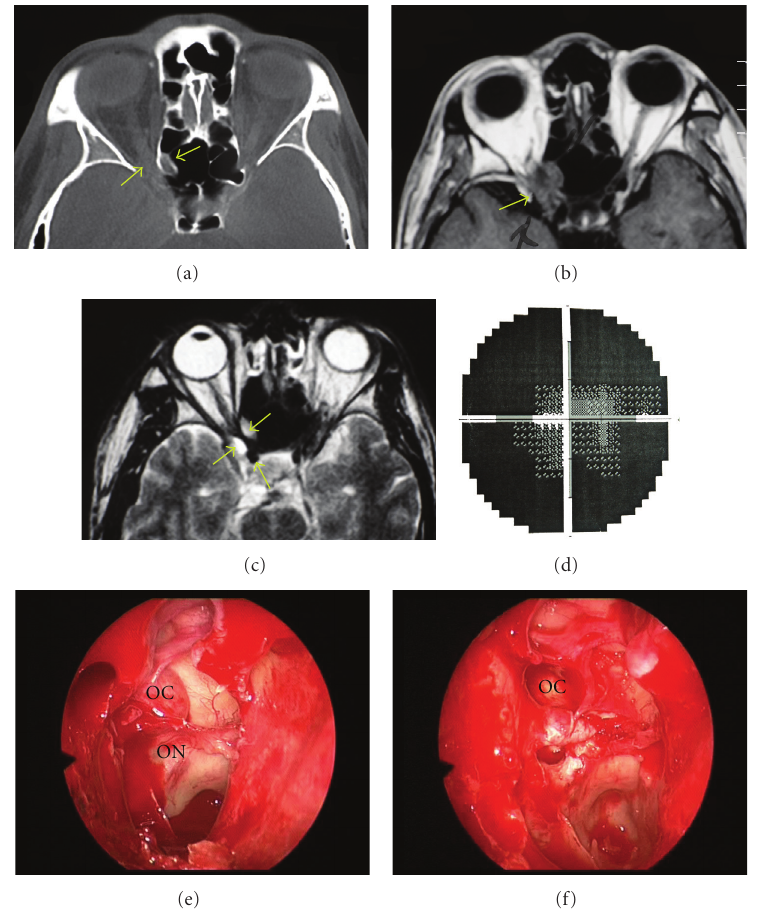
Figure 1: (a) Orbital CT imaging of a right Onodi cell mucocele compressing the optic nerve (arrows). (b) T1-weighted MRI image showing a hypointense signal due to the water content in the Onodi cell (arrows). (c) T2-weighted MRI image with a high signal intensity within the Onodi cell (arrows). (d) Humphrey visual field of the right eye with significant constriction of the visual field. (e) A clinical photograph of the Onodi cell mucocele (OC) and the optic nerve (ON) prior to decompression. (f) A clinical photograph following marsupialisation of the Onodi cell and drainage of the mucocele